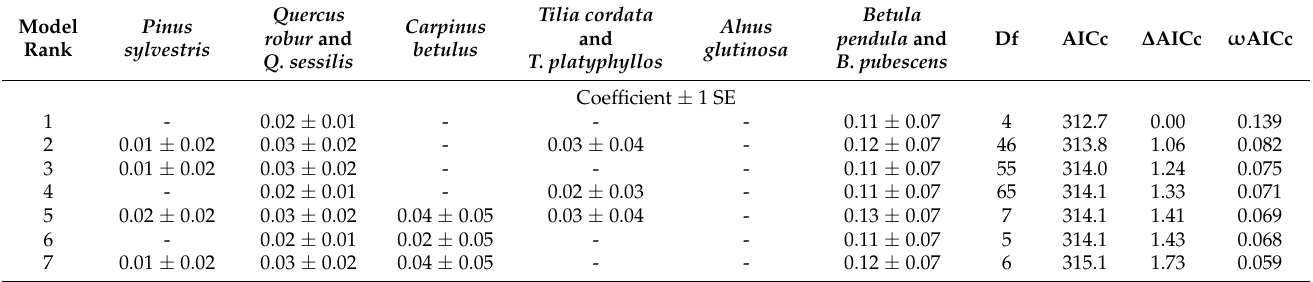
Table 6. The highest-ranking models predicting species richness of secondary cavity nesters in